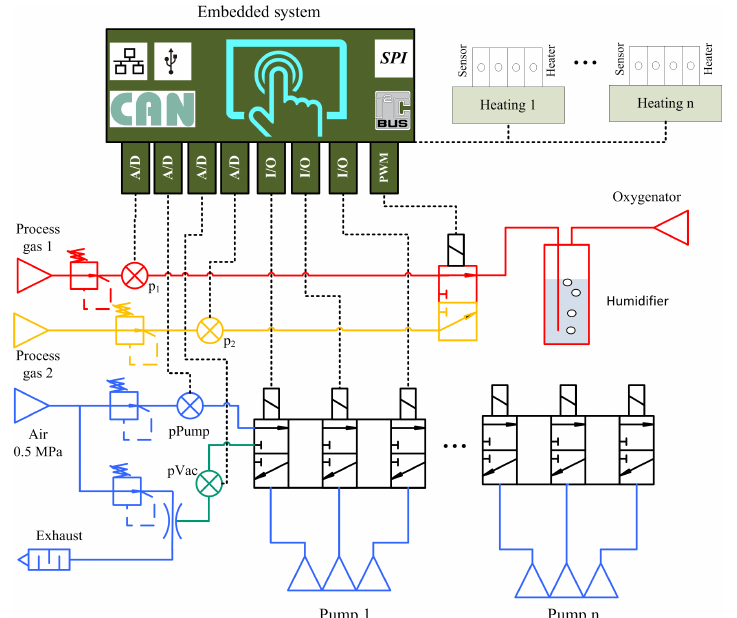
Figure 2. Block diagram of the controlling system.